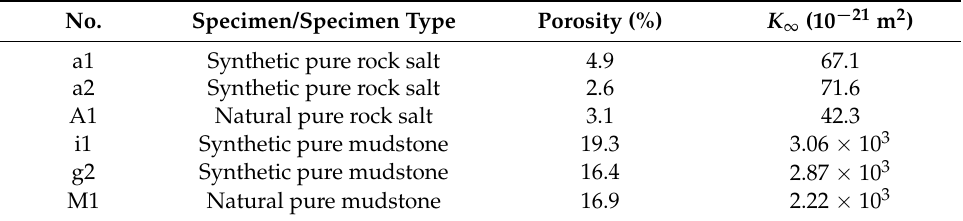
Table 7. The porosity and permeability of the synthetic specimens and natural rock specimens. Specimen No.